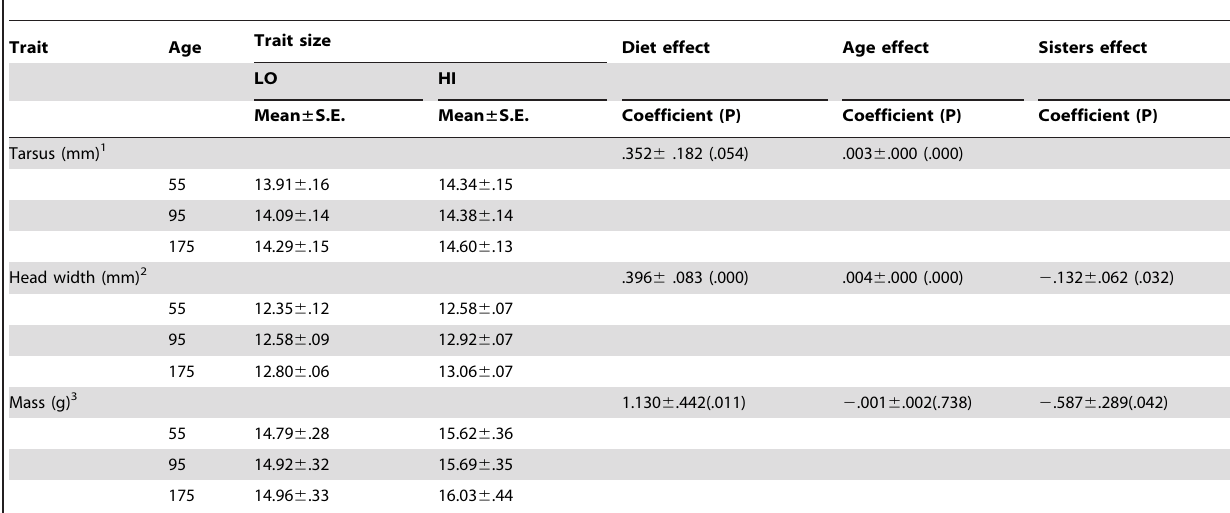
Table 1. Effects of diet treatment, age, and natal brood composition (‘‘sisters’’) on size traits of male zebra finches.